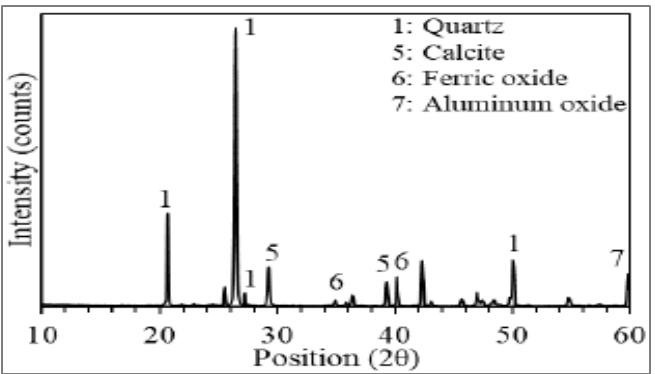
Figure 2. XRD of dune sand